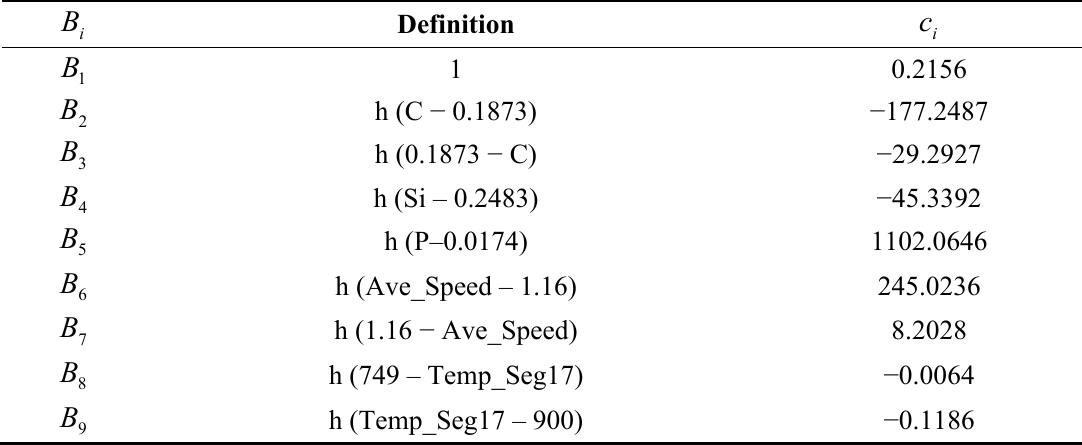
Table 4. List of basis functions of the MARS model for the average width (Ave_Width) and their